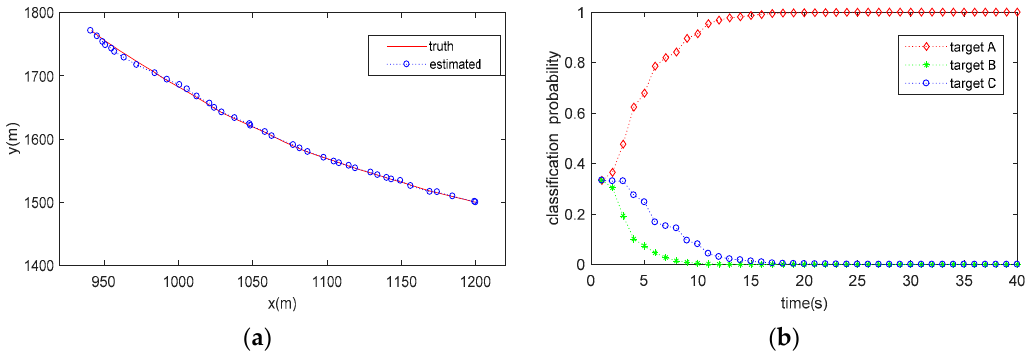
Figure 3. Result of JTC when Target Class A is present: ( a ) estimated target trajectory; ( b ) estimated target class probability.